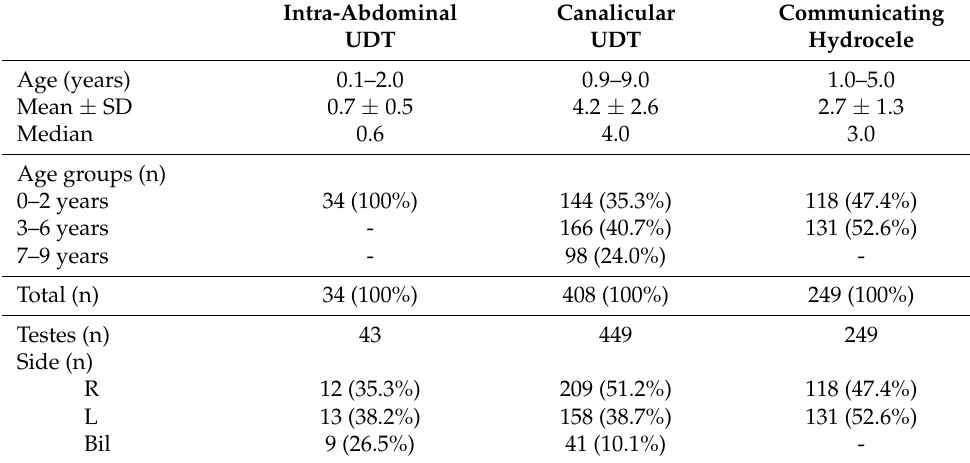
Table 1. Patients’ Table 1. Patients’ characteristics. Table 1. Patients’ characteristics. Table 1. Patients’ characteristics. Table 1. Patients’ characteristics.